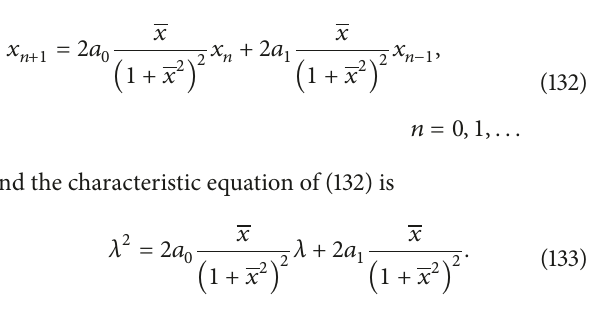
Figure 2 for visual interpretation of case